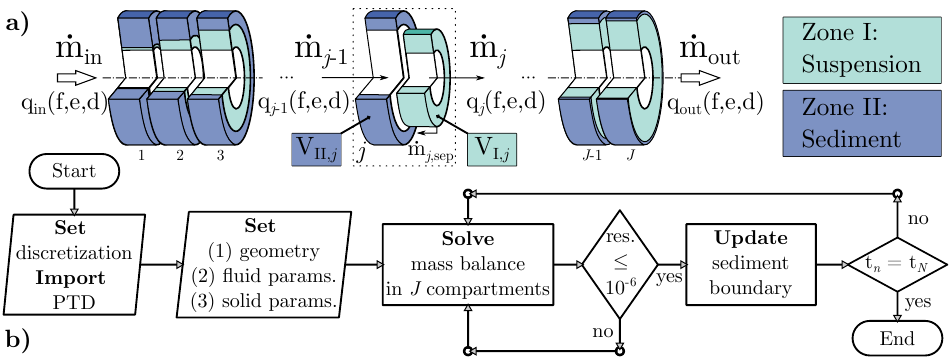
Figure 3. Spatial discretization of the separation zone in j = { 1,2, . . . , J } compartments with illustra- tion of incoming and outgoing flows ( a ); Flow chart of the simulation algorithm ( b